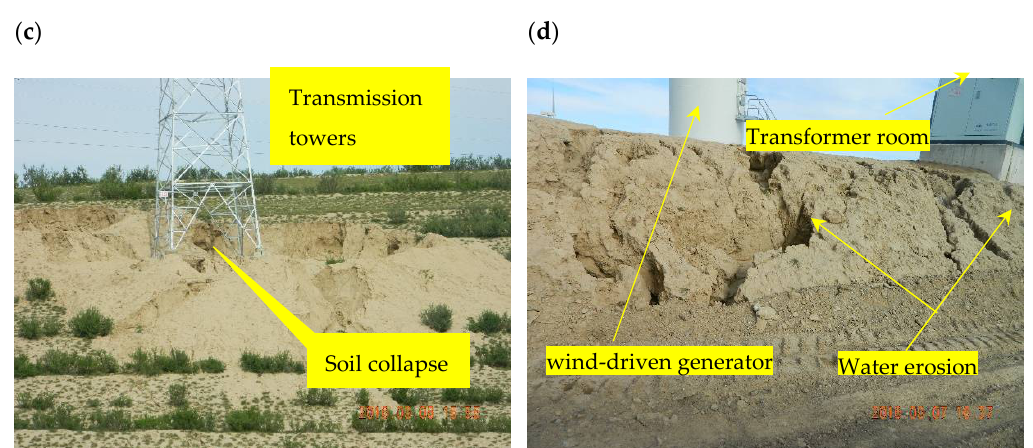
Figure 3. On-site view of 8 September 2016, water erosion caused by wind power project in Haiyuan County, Ningxia Province. ( a ) Water erosion destroyed the provisional road. The road was built to ensure that vehicles, personnel, and materials could be timely transported to the construction site during the construction of the wind power project. ( b ) Water erosion destroyed the drainage ditches. Because no protection measures had been implemented for the slope which was cut very steeply, resulting in serious water erosion and destroying the drainage ditches beneath the slope. ( c ) Soil collapse threatened the safety of transmission towers. ( d ) Water erosion occurred around the wind-driven generator and transformer room. If water erosion was not controlled, the safety of the wind-driven generator would be threatened.